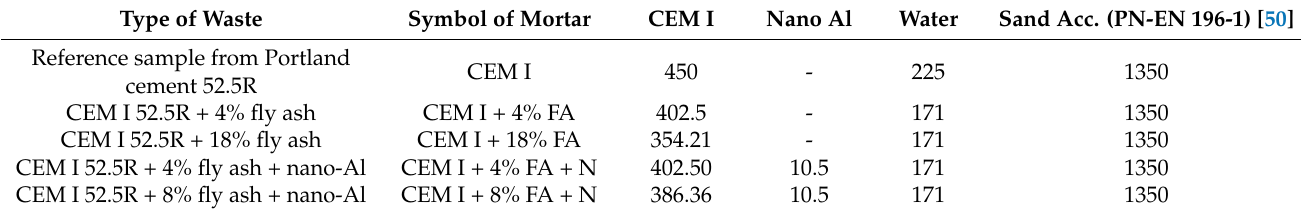
Table 3. Composition of the concrete mortars, expressed in